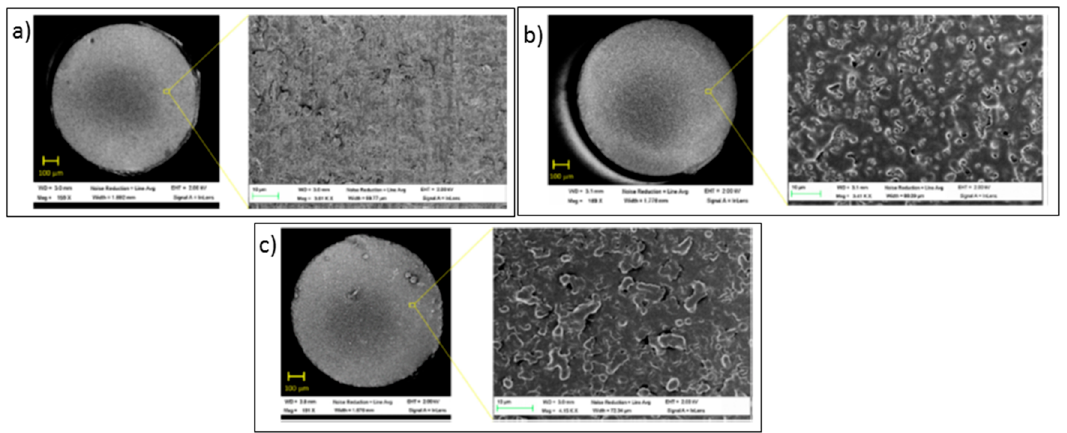
Figure 35. SEM images obtained from sensor heads deposited with Pt-TFPP with 3 different cationic polymers: ( a ) PDDA, ( b ) PEI and ( c ) PAH. A general view of the fibre and a detailed area of the coating is displayed for each coating. Reprinted from [165] with permission from Elsevier.